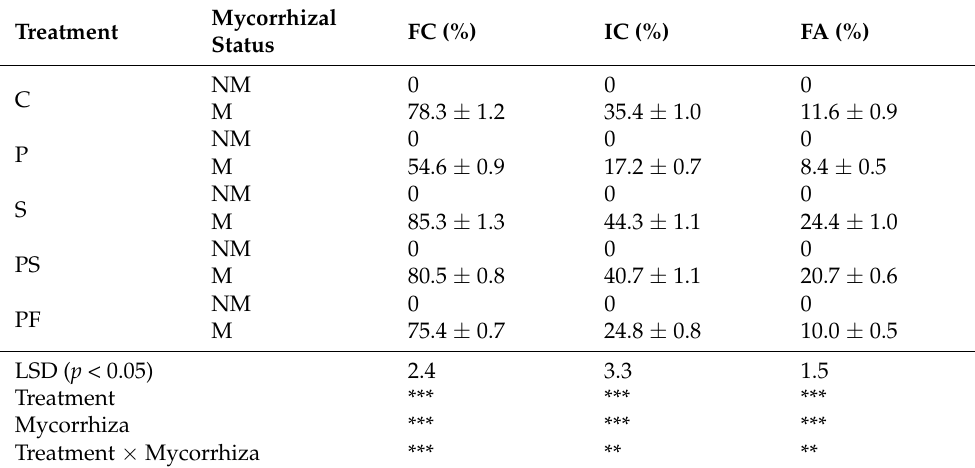
Table 7. Effects of application of S. viridosporus HH1 on colonization level with R. irregularis in roots of pea plants (cv. Master-B) infected/or not with Fusarium wilt at 30 days post planting a .